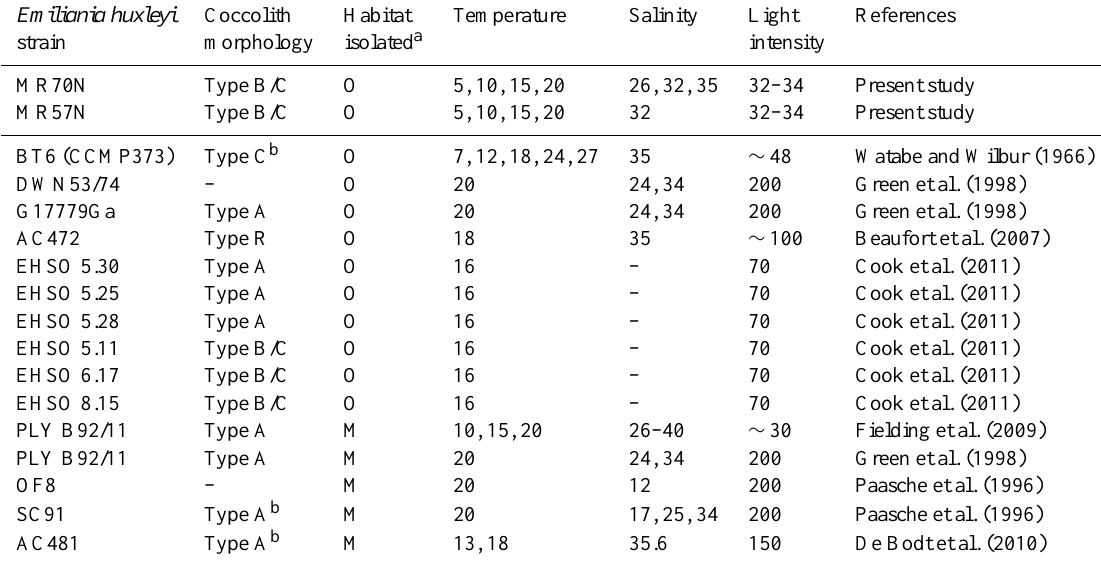
Table 3. List of coccolith morphology of Emiliania huxleyi strains in laboratory culture experiments. Emiliania huxleyi Coccolith Habitat Temperature Salinity Light strain morphology isolated